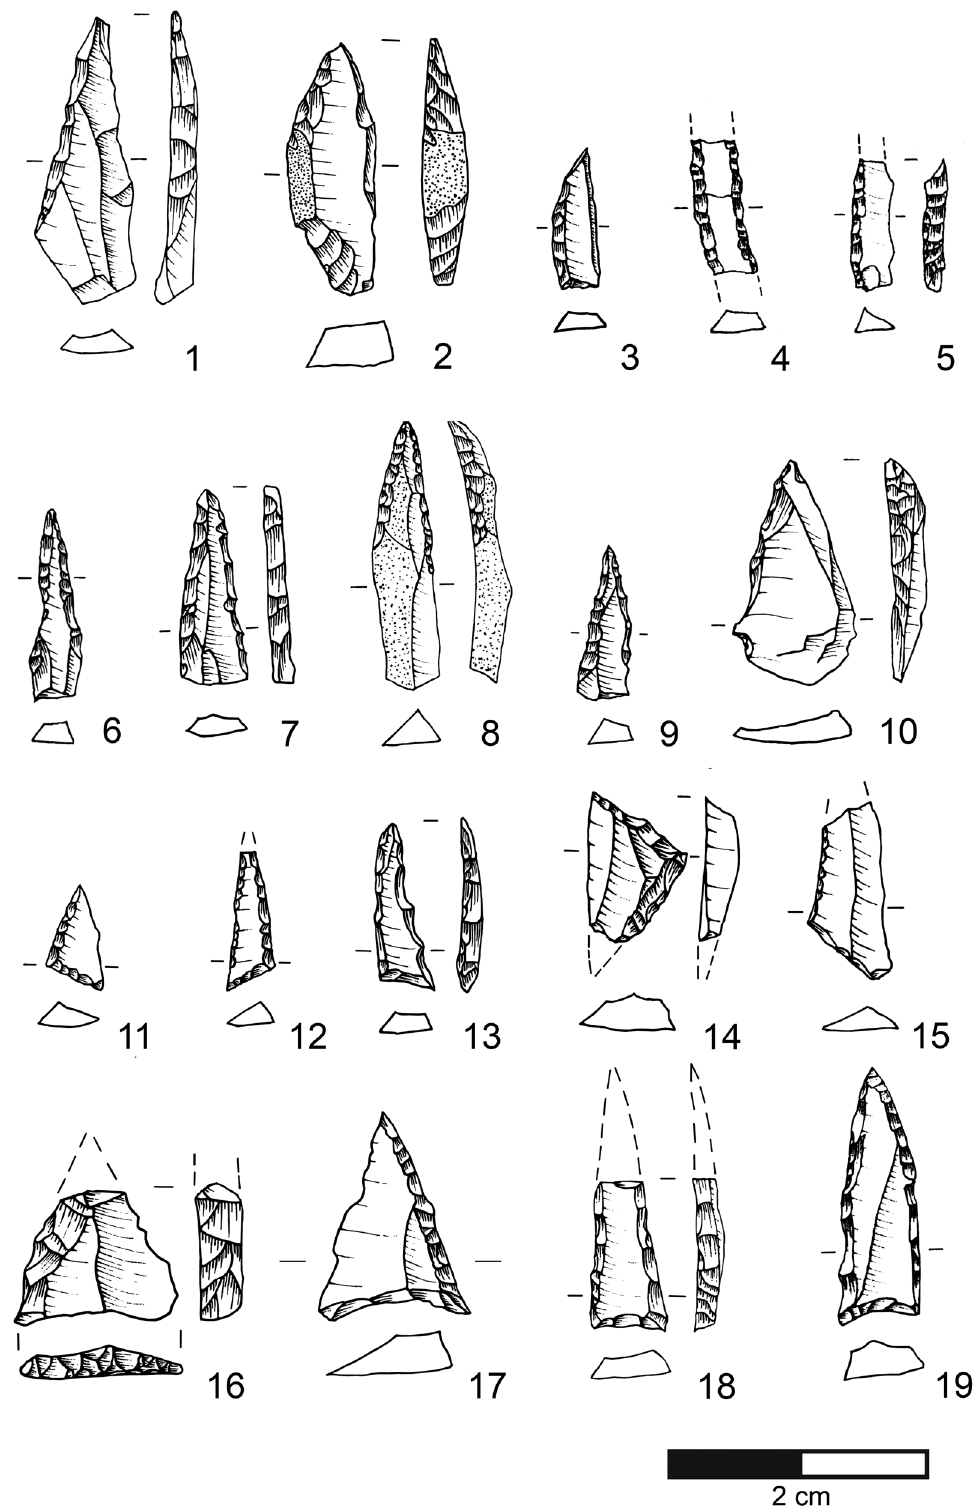
Figure 7: Microliths Schneiderküren ( selection ) : 1 Truncated micro - point, 2 – 3 cresents, 4 – 5 backed bladelets, 6 – 8 meches de fôret, 9 – 10 micro - point, 11 – 15 scalene triangles, 16 – 19 micro - points with base retouche. Drawings: B.